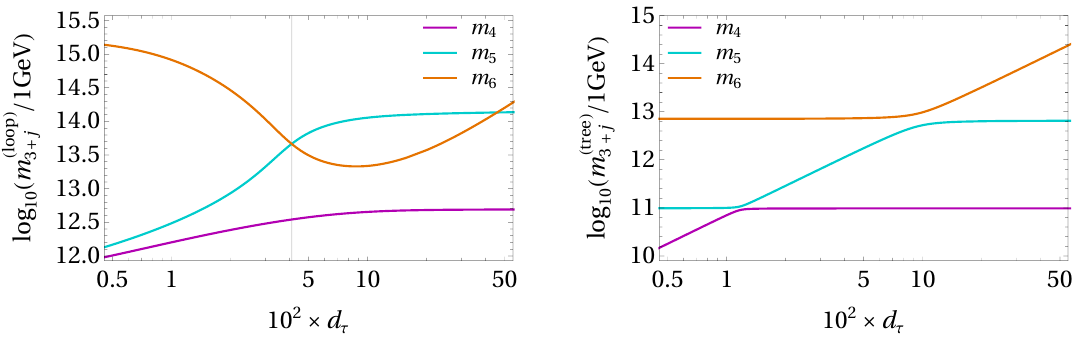
Figure 2 . m (loop) (left panel) and m (tree) (right panel) against d τ in a case where all other input 4 , 5 , 6 4 , 5 , 6 parameters are kept fixed at values given in the main text. The Yukawa coupling d τ is defined in